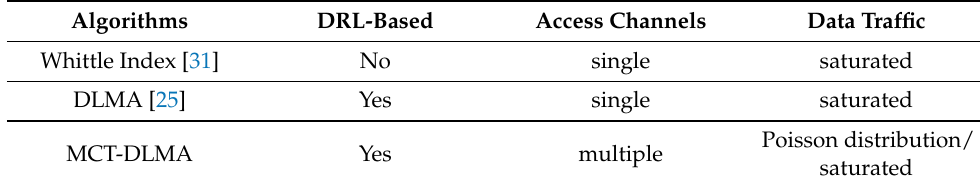
Table 1. Approach